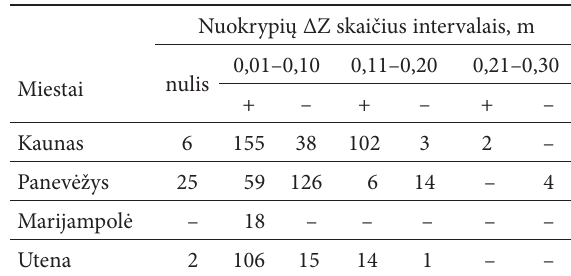
Table 5. Distribution of heights deviations